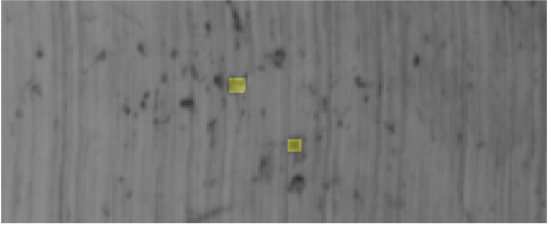
Figure 9. The two false negatives (yellow) that were predicted by the system. The underlying scan exhibits small defects, but below the tolerance threshold.